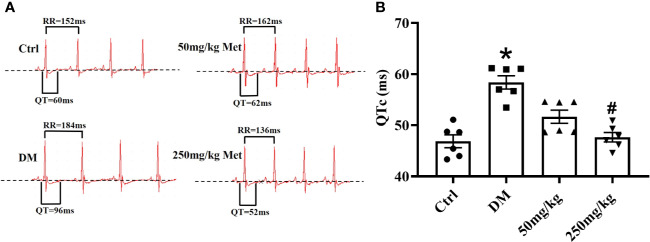
The effect of metformin on QTc in diabetic mice after 4 weeks of treatment. (A) Representative electrocardiogram traces recorded from surface ECG in the Ctrl group, DM group, and the metformin-treatment group for 4 weeks. (B) The relative level of QTc interval of the Ctrl group, DM group, and the metformin-treatment group. Values represent mean ± SEM, nCtrl = nDM = nMetformin = 6. *P < 0.05 versus Ctrl, #P < 0.05 versus DM.